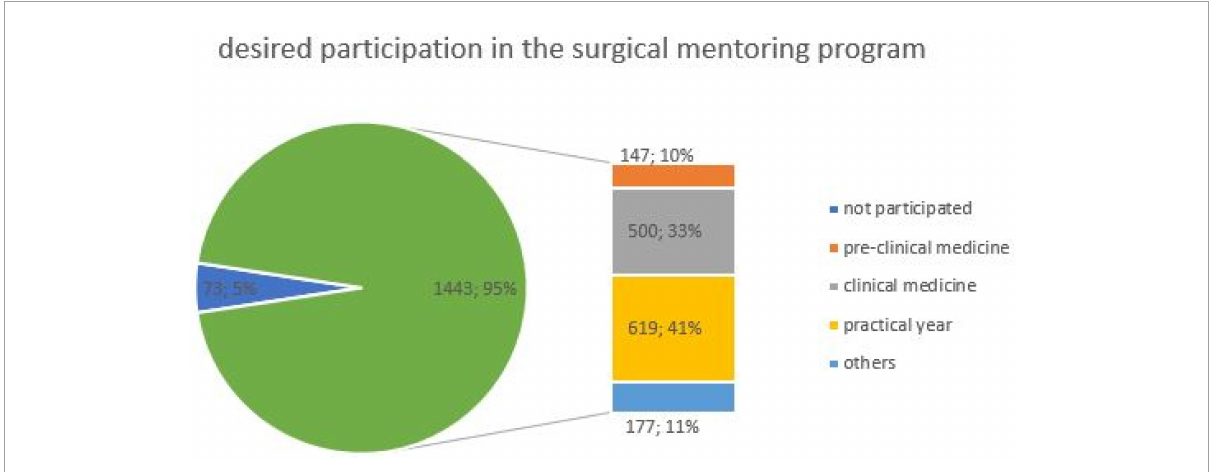
FIGURE4 Distribution of students who wished to participate in a surgical mentoring program ( n = 1,516). The figure is divided according to the participation mentoring program in the pie chart (blue: not participated, green: participated) and divided by the study period in the bar